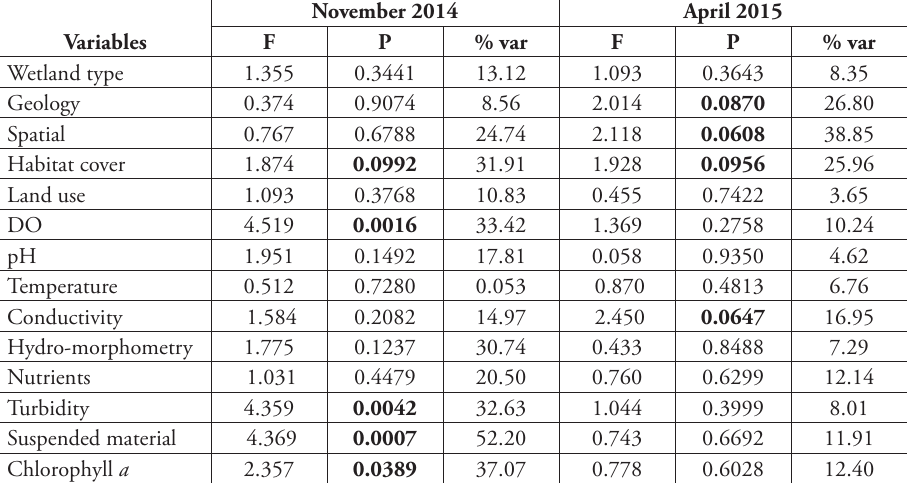
Table 4. Tests for relationships between the composition of large branchiopod assemblages and environ- mental predictor variables, either singular or in sets, using the dbRDA multivariate F-statistic. P values less than 0.10 are highlighted in bold. The column headed ‘% var’ indicates the percentage of multivariate assemblage variation (in terms of Bray-Curtis similarity) that is explained by the particular variables or sets of